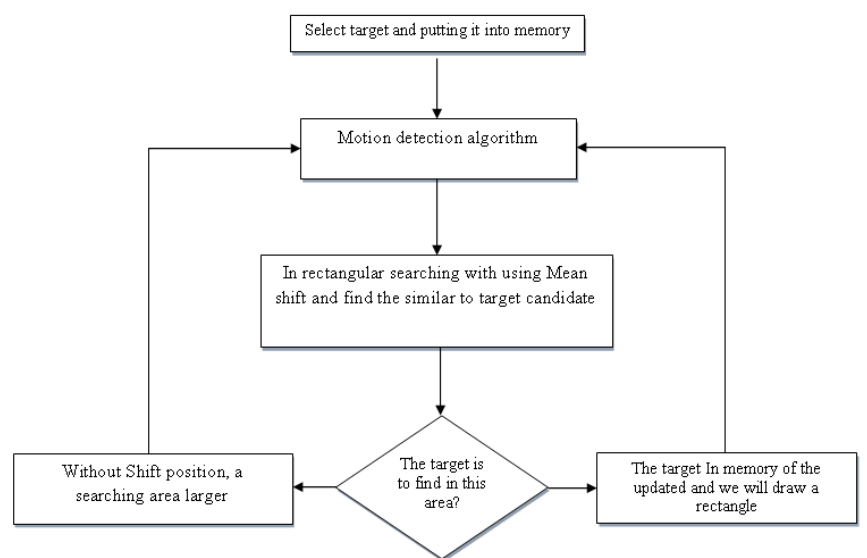
Figure 1.Complete block diagram of integration